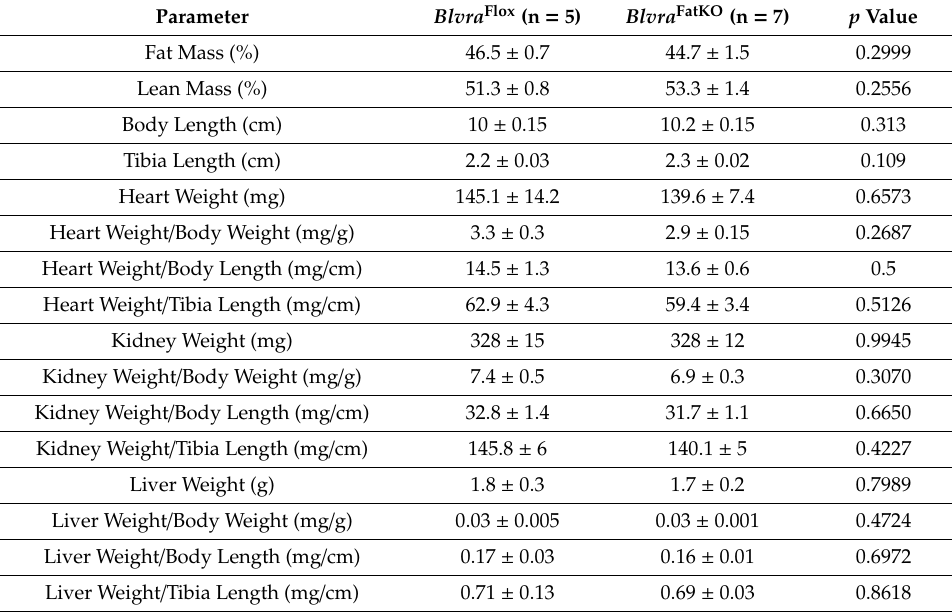
Table 1. Fat and lean mass percentage and tissue weights in Blvra Flox and Blvra FatKO .